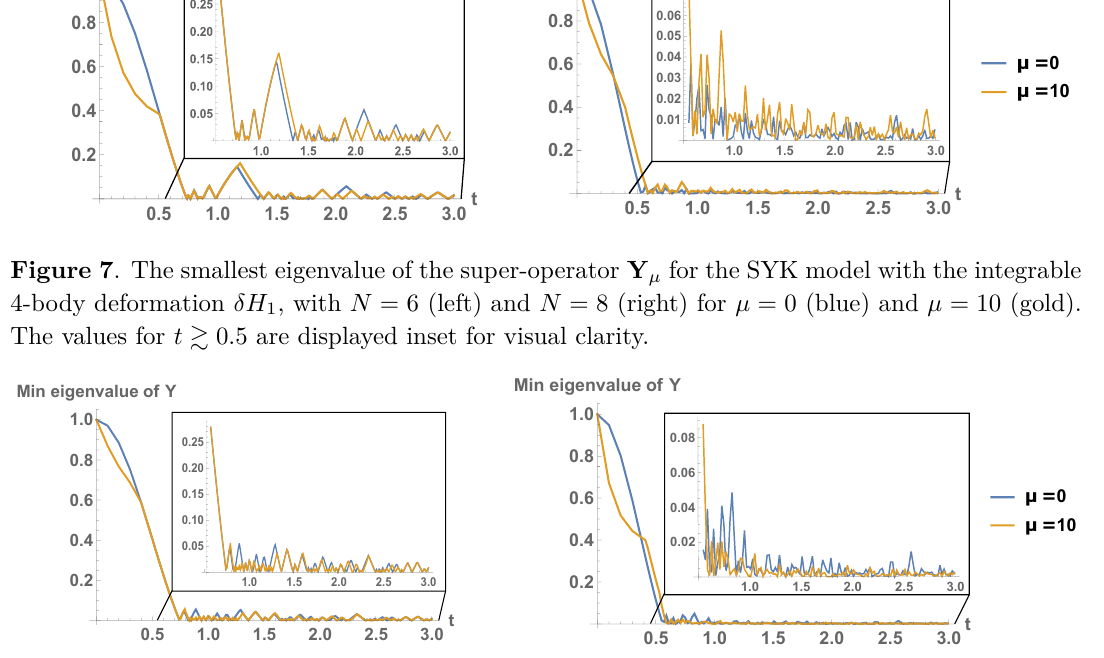
Figure 8 . The smallest eigenvalue of the super-operator Y µ for the SYK model with the chaotic 4-body deformation δH 2 , with N = 6 (left) and N = 8 (right) for µ = 0 (blue) and µ = 10 (gold). The values for t & 0 . 5 are displayed inset for visual clarity.